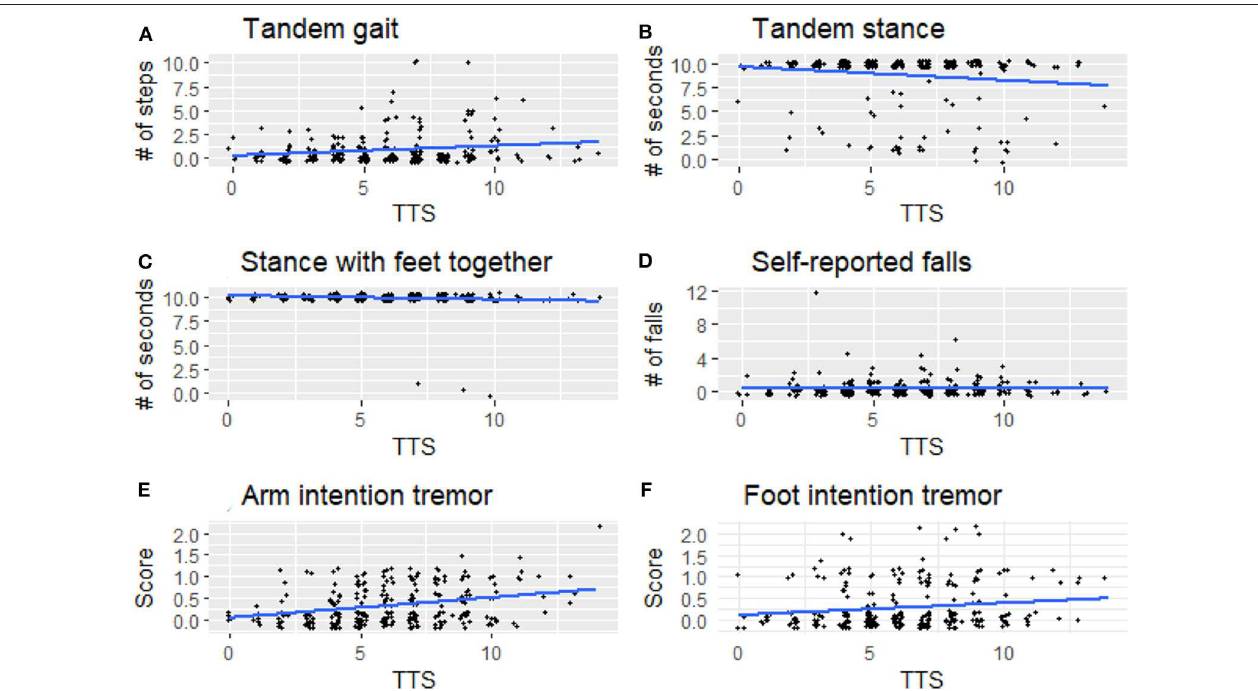
FIGURE 2 | Signs of cerebellar dysfunction [ (A) tandem gait, (B) tandem stance, (C) stance with feet together, (D) self-reported falls, (E) arm intention tremor, (F) foot intention tremor] plotted against TTS. TTS, total tremor